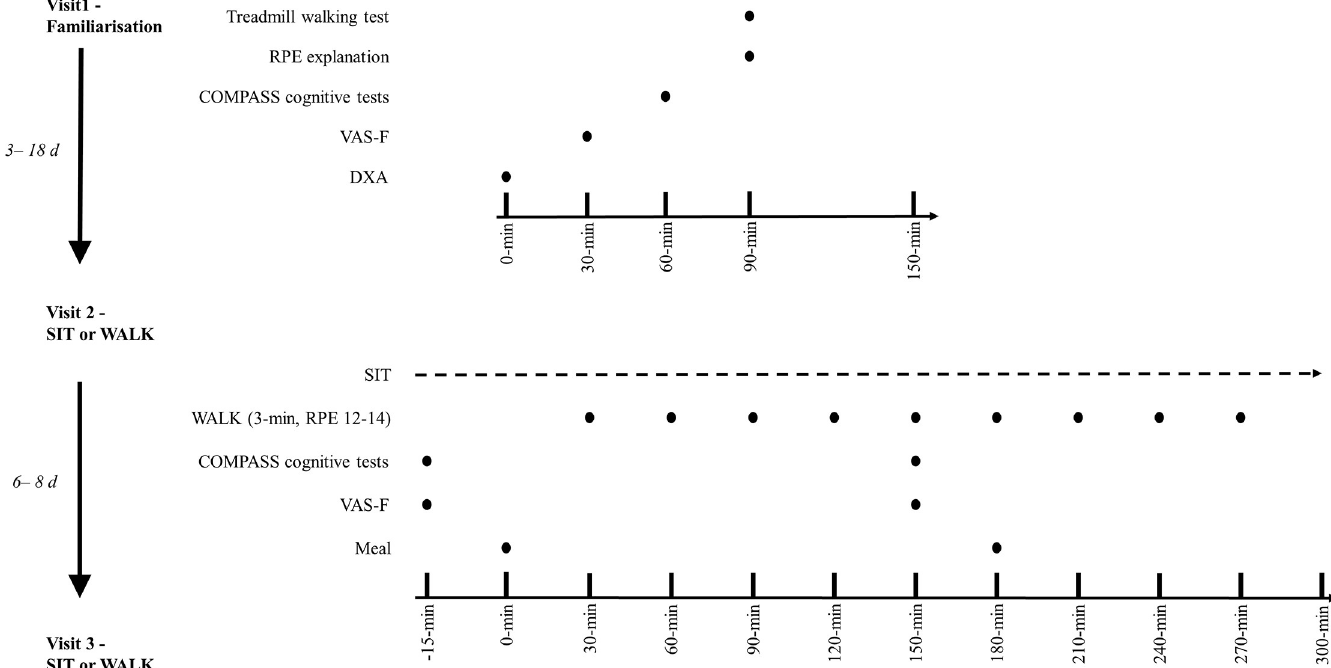
Fig 1. Experimental schematic. SIT = uninterrupted sitting; WALK = breaking up sitting with walking. Both conditions are identical except in SIT, no walking breaks occurred.